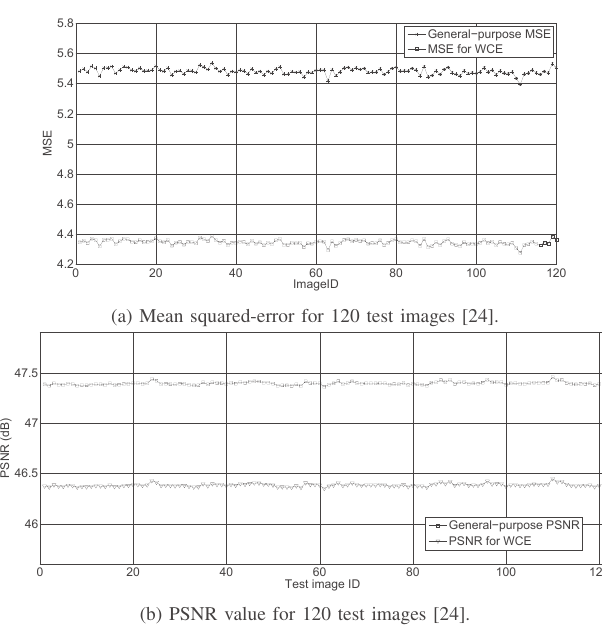
Fig. 5. Comparison of the MSE and PSNR values for the conventional and proposed IQA methods. TABLE I T HE COMPARISON OF DIFFERENT IMAGE QUALITY ASSESSMENT METHODS